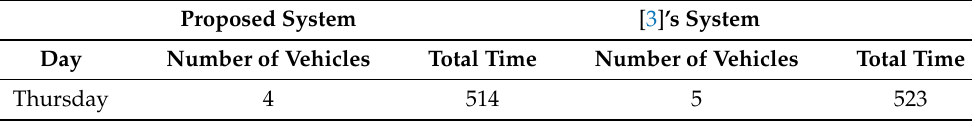
Table 2. Comparison of the proposed solution and